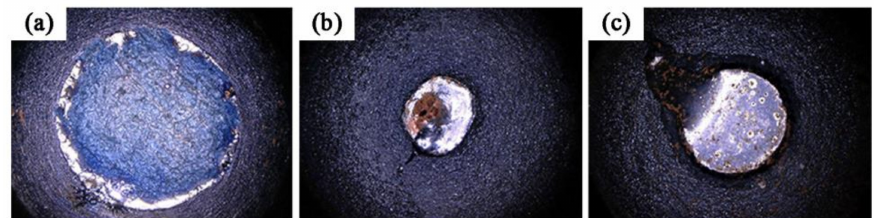
Figure 7. The fracture morphology of VH steel after hot tensile test at different temperatures: ( a ) 700 ◦ C, ( b ) 1000 ◦ C and ( c ) 1200 ◦ C.